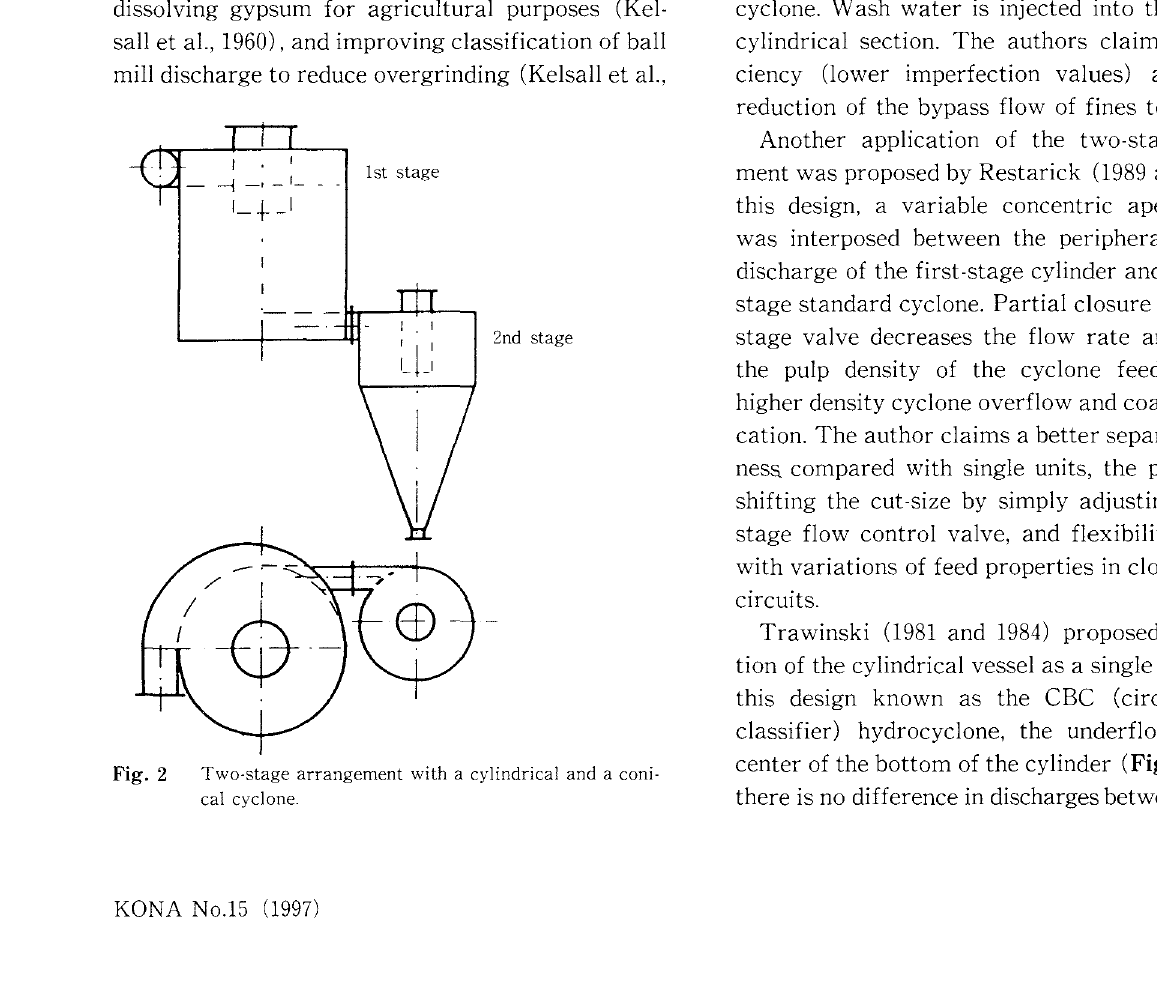
Fig. 2 Two-stage arrangement with a cylindrical and a coni cal